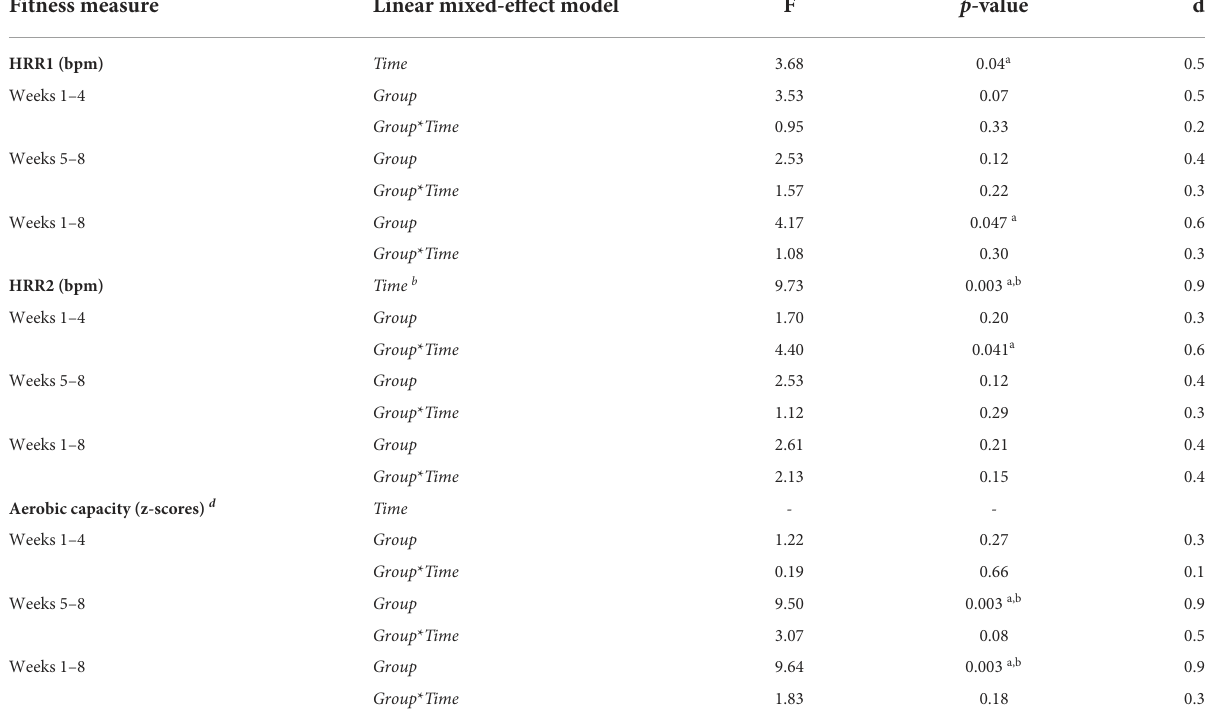
TABLE 4 Exercise engagement effect on